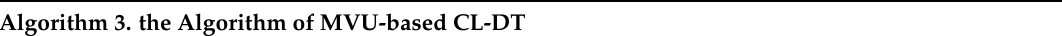
Algorithm 3. the Algorithm of MVU-based